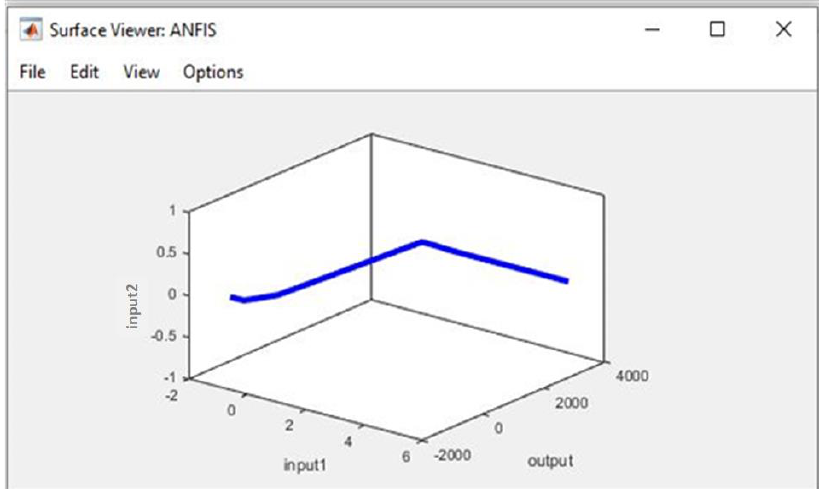
Figure 9. The MATLAB simulation output surface of the ANFIS.